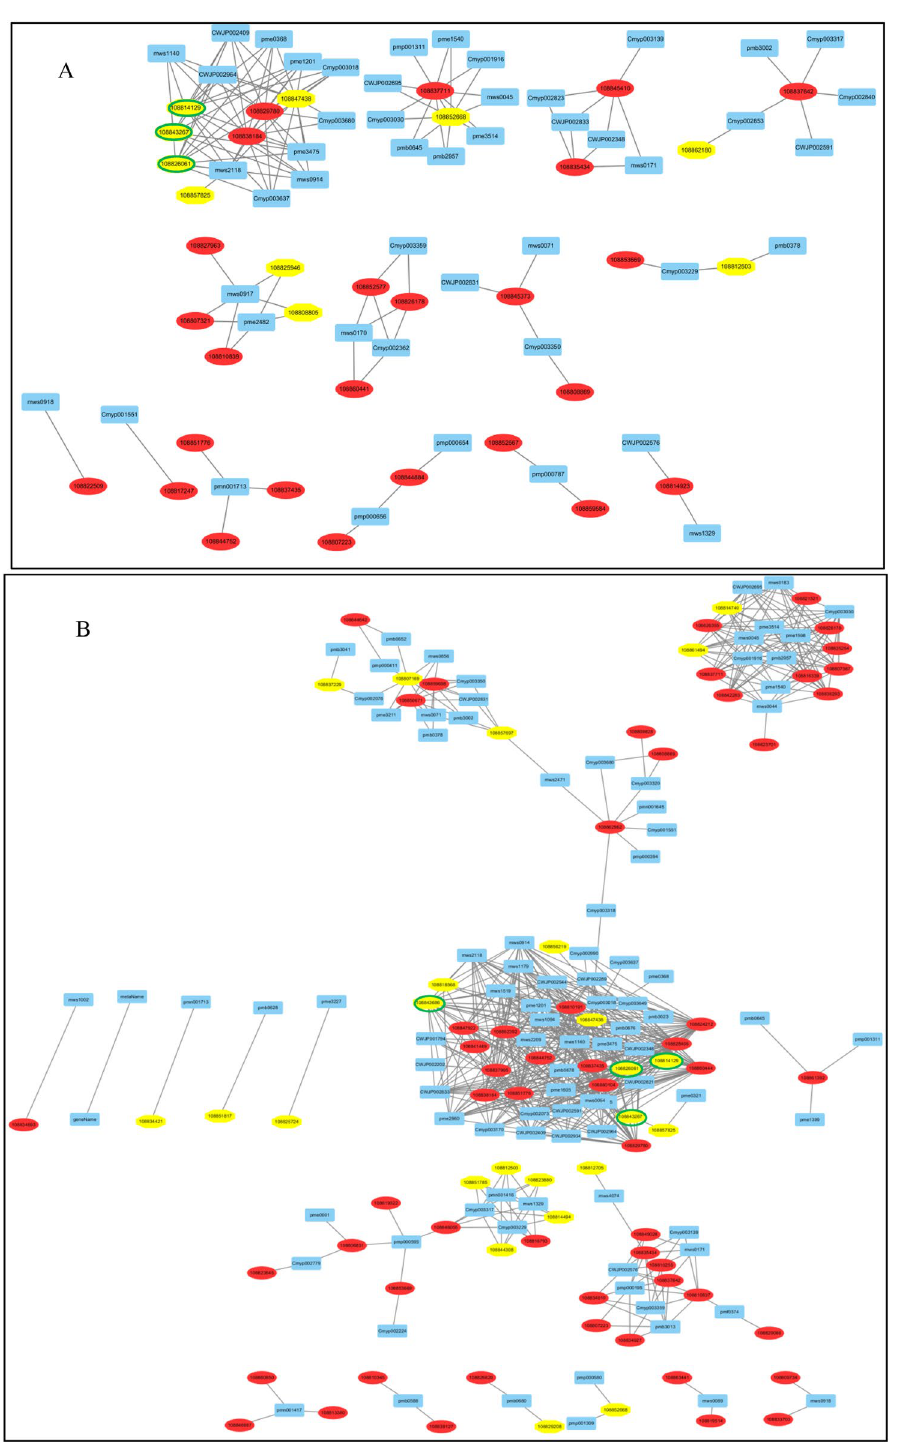
Figure 5. Connection network between the structural genes, TFs, and flavonoid-related metabolites. ( A ) Network between the genes and flavonoid metabolites in the taproot skin. ( B ) Network between the genes and flavonoid metabolites in the taproot flesh. Only genes with correlation coefficients > 0.95 are shown. Yellow circles with green frames represent the ID of structural genes involved in flavonoid biosynthesis; the other yellow circles represent the ID of structural genes involved in phenylpropanoid biosynthesis; the red circles indicate the TFs, and the blue boxes represent flavonoid-related metabolites. A and B were visualized using Cytoscape v2.8.2 (https:// cytos cape.